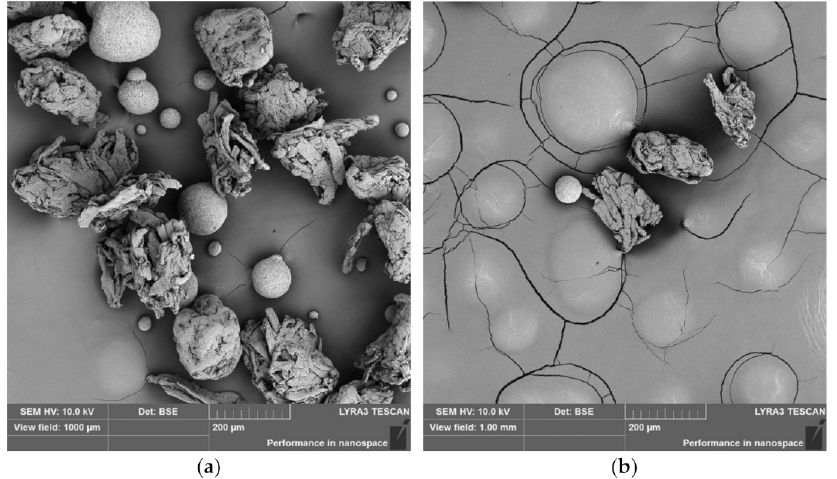
Figure 1. SEM/BSE (backscattered electron) image of microcrystalline cellulose mixture with 10% of Neusilin ® US2 ( a ) or 1% Neusilin ® S2 ( b